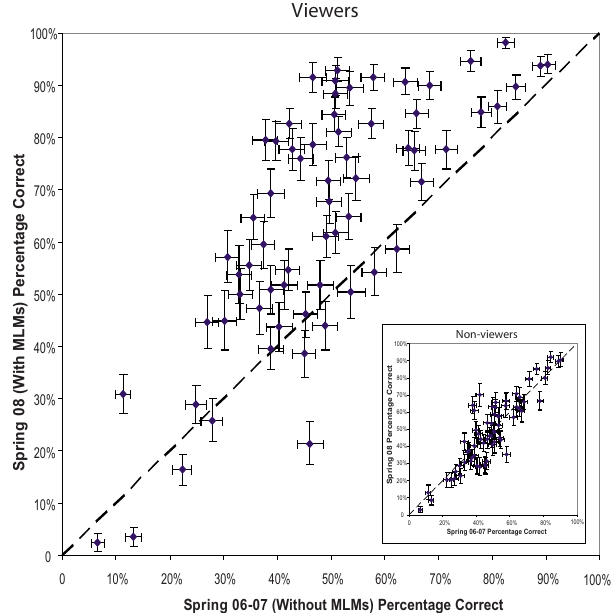
FIG. 2. (cid:1) Color (cid:2) Preflight performance of viewers in Spring 08 semester. The y -coordinate of each data point represents the per- centage of correct answer for one preflight question among viewers in Spring 08 semester. The x -axis is the same as in Fig. 1. Inset: preflight performance of Spring 08 nonviewers.